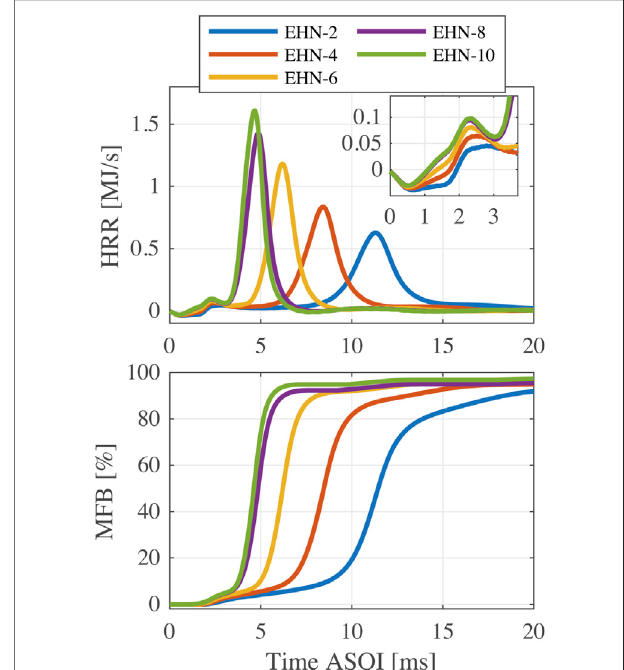
FIGURE 5 | HRR and MFB pro fi les of n-butanol and EHN blends with EHN mass fractions of 2% – 10% ( T wall = 580 °